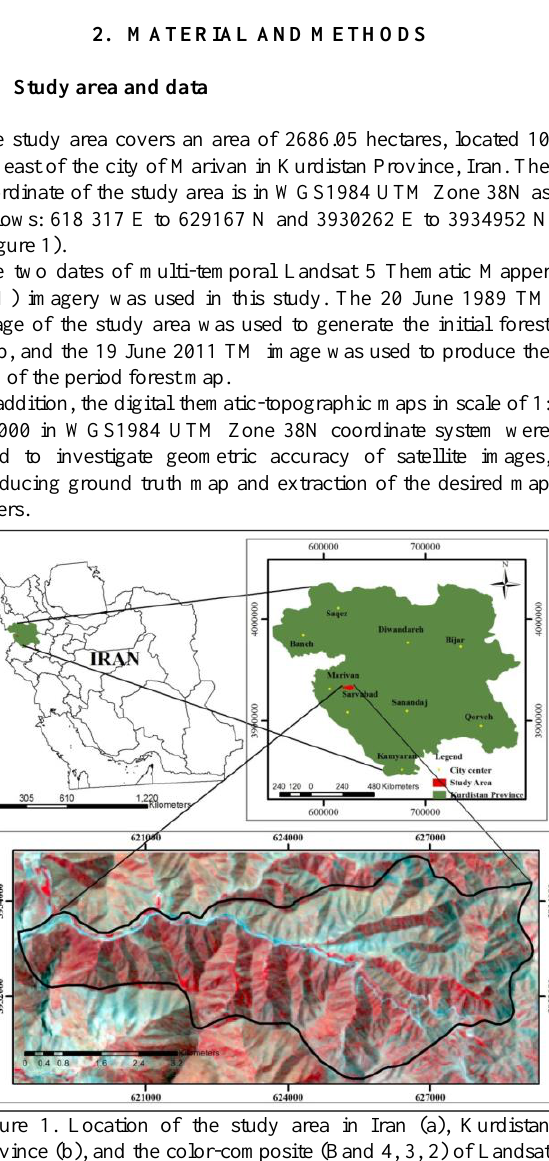
Satellite images were downloaded from the internet site of United States Geological Survey (USGS), at L1T correction level (terrain corrected level). In order to better extraction of information from satellite images, some processing such as spectral rationing, producing of vegetation indices and principal component analysis was performed on the images. The normalized difference vegetation index (NDVI) and soil- adjusted vegetation index (SAVI) were used in this